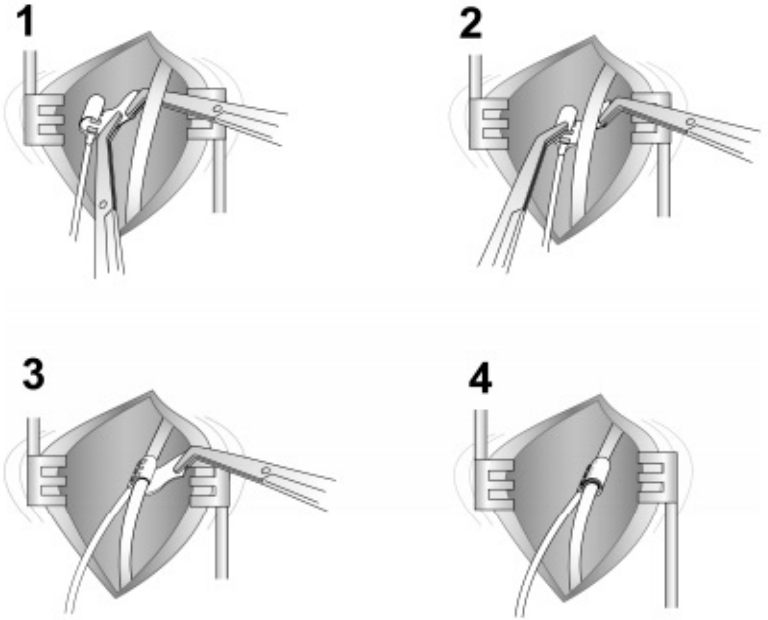
Figure 9. The neck incision (placing the cuff around the hypoglossal nerve). The steps of placing the cuff around the hypoglossal nerve 1–4.